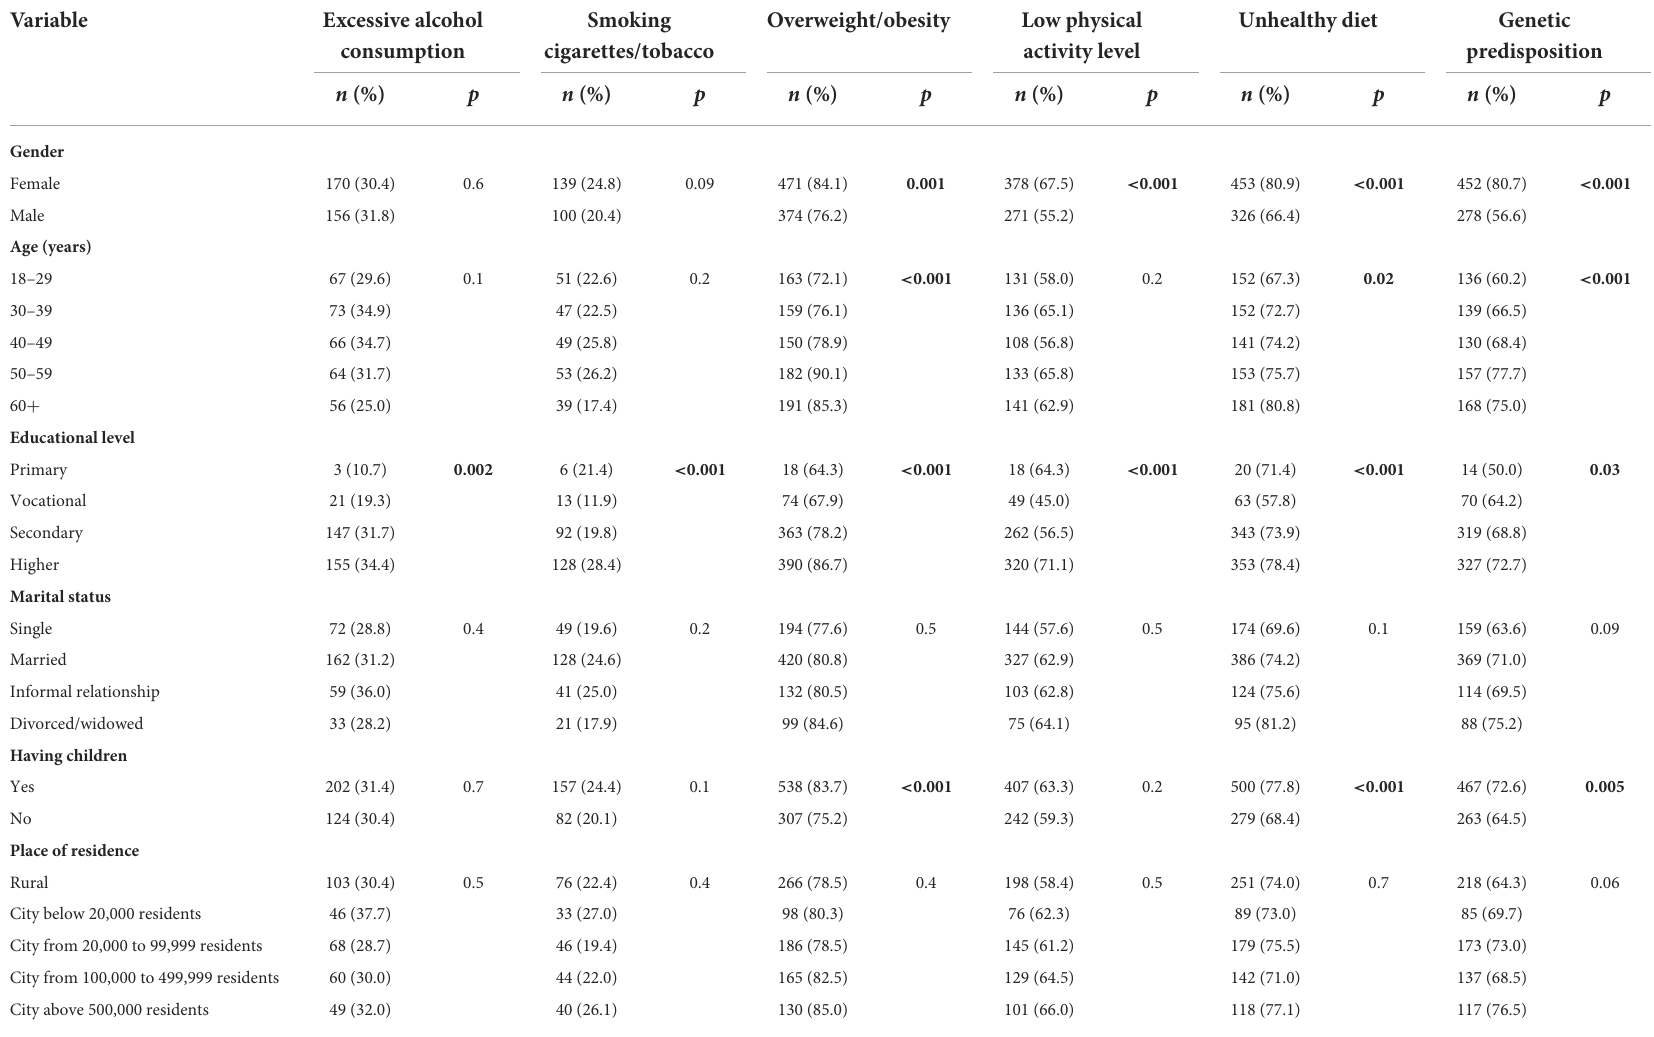
TABLE 4 Awareness of risk factors for diabetes by sociodemographic factors ( n = 1,051). Risk factors for diabetes - percentage of respondents who answered “yes” by sociodemographic factors Variable Excessive